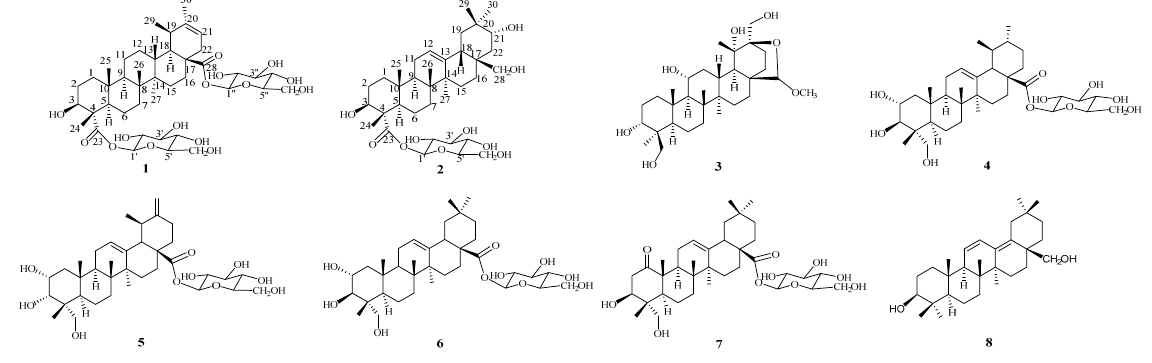
Figure 1. The structures of compounds ( 1 )–( 8 ) from H .